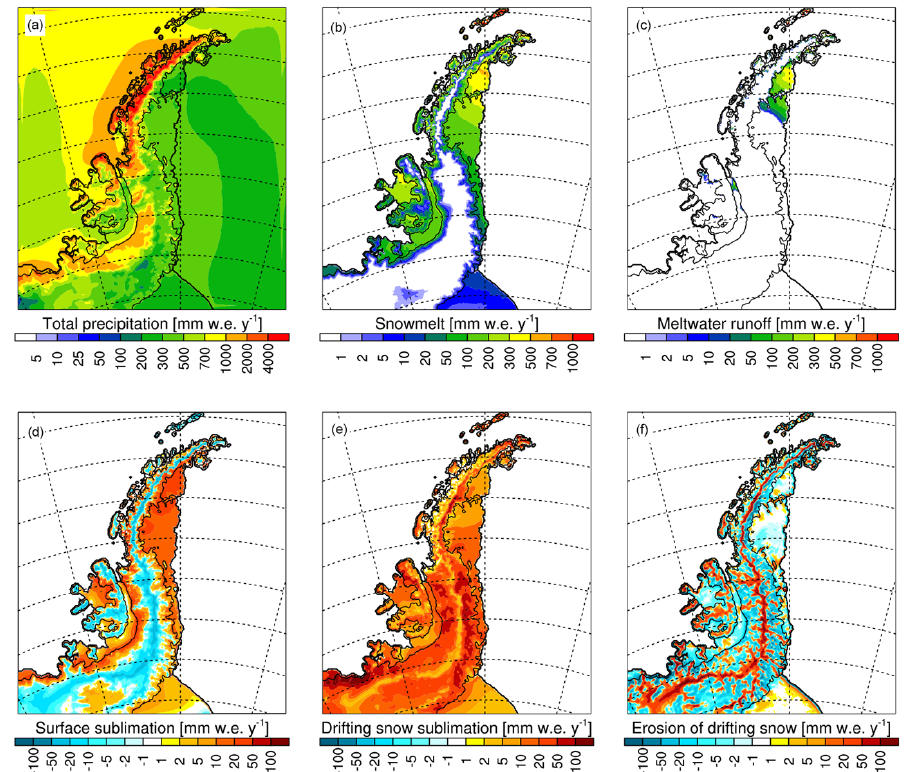
Figure 5. 1979–2014 average SMB components: total precipitation (snowfall + rain) (a) , snowmelt (b) , meltwater runoff (c) , total sublima- tion (d) , sublimation of drifting snow (e) and erosion of drifting snow (f) in mmweyr − 1 . Note that ablation is defined positive in (d – f) . All fluxes are from RACMO2.3, except for runoff, which is calculated by the FDM that is forced by RACMO2.3